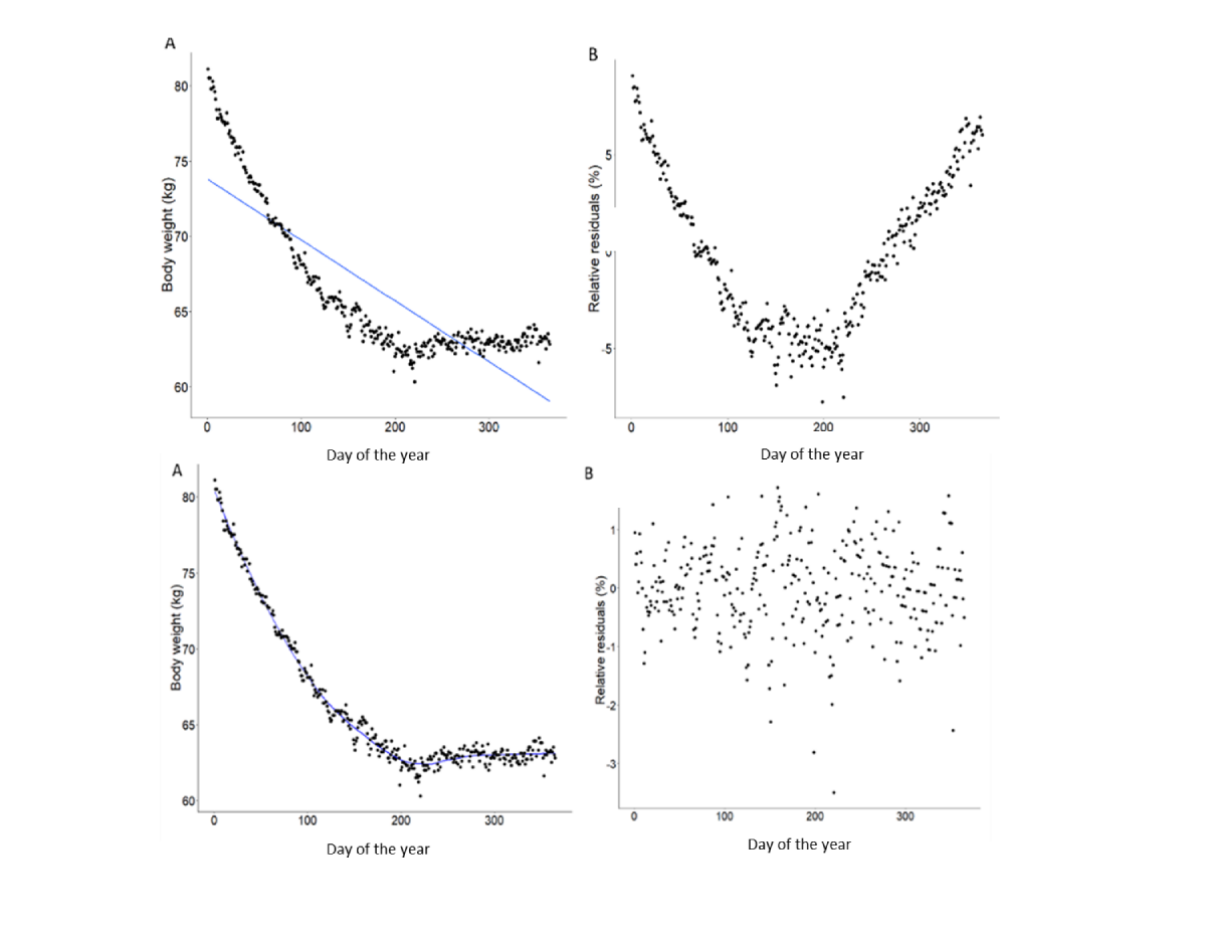
Figure 2. Performance summaries of univariate and multivariate imputation. Boxplots of the errors associated with imputation of body weight data collected by smart scales. Data was removed by a missing completely at random algorithm (left plots) and also informed by real patterns of missingness (right plots) in increments of 20%, 40%, 60% and 80%. Imputation was done by 7 univariate methods (top plots) and 3 multivariate methods (bottom plots). Root mean square error was used as the performance metric. ASSRKS: ARIMA state-space representation and Kalman smoothing; EWMA: exponentially weighted moving average; KNN: K-Nearest neighbors; Lin Int: linear interpolation; PMM: predictive means matching; RF: random forest; RMSE: root mean square error; SMKS: structural modelling with Kalman smoothing; Spline int: spline interpolation; Stine int: stine